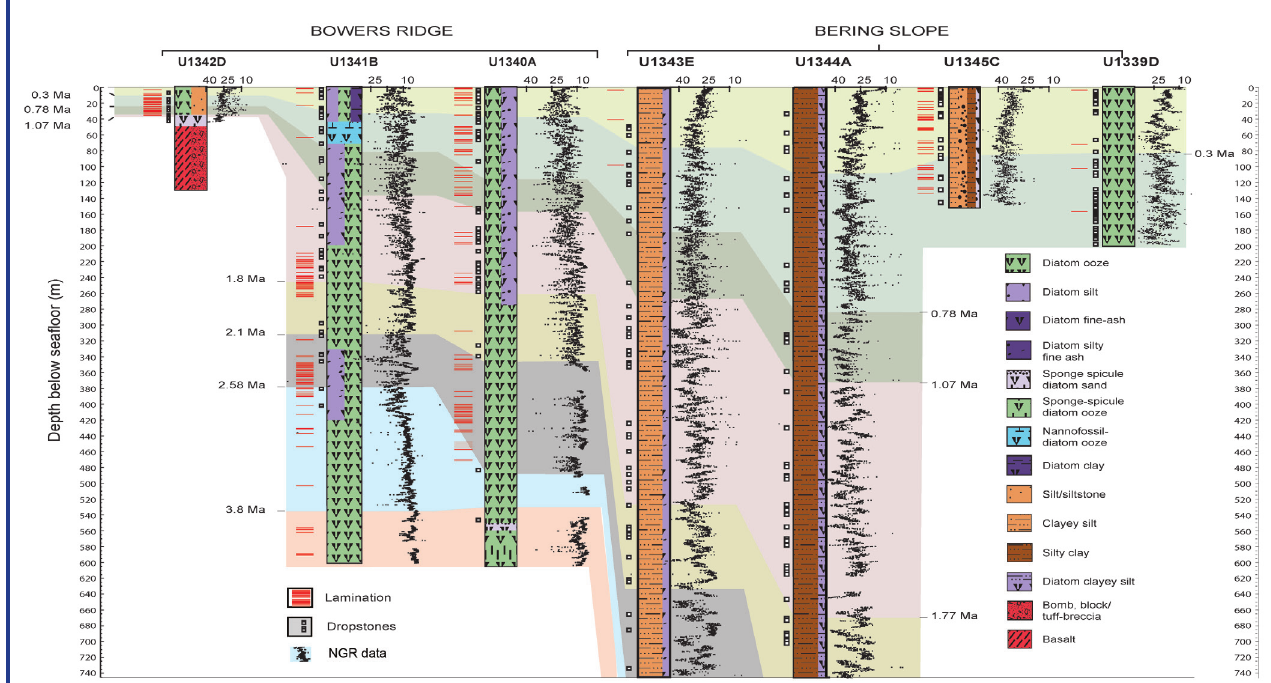
Figure 4. Lithostratigraphic summary of Exp. 323 drill sites. Natural gamma radiation (NGR: counts s -1 ) data are plotted in black at the right side of the lithology columns (values increase to the left). Laminations are denoted by red horizontal lines. Note that there are many different styles of laminations; future work will determine which laminations are primary features, and which are